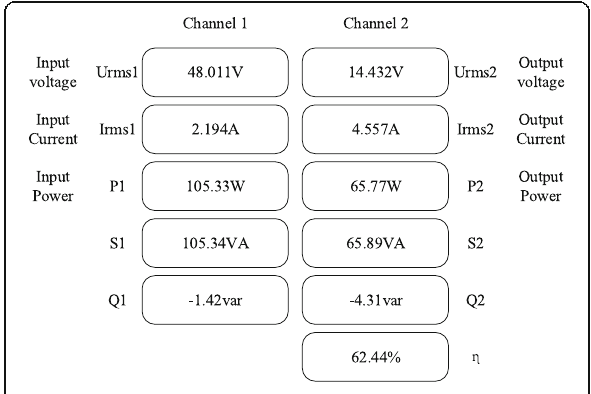
Fig. 12 System power transmission capability